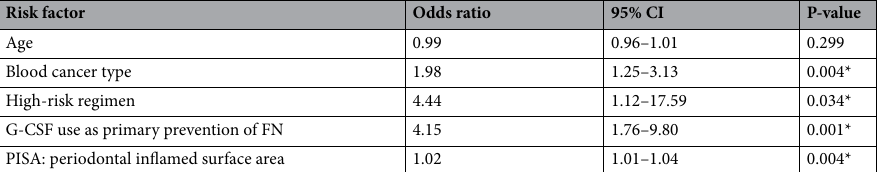
Table 3. Multivariate logistic regression analysis to identify predictive factors for FN. *Based on 5 factors included for analysis showing a P value < 0.05 by univariate analysis, conducted using a Mann–Whitney U test, chi-square, or univariate logistic regression test. *P < 0.05 (statistically significant in multivariate logistic regression via forced-entry